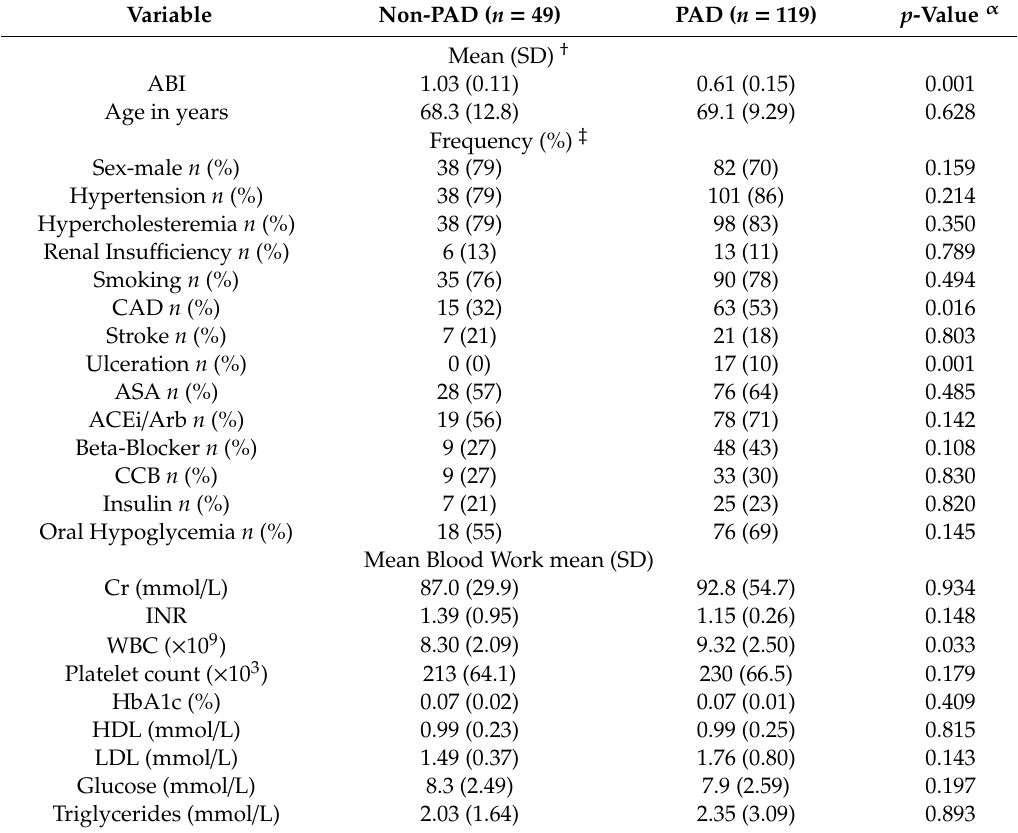
Table 1. Patient demographics and clinical